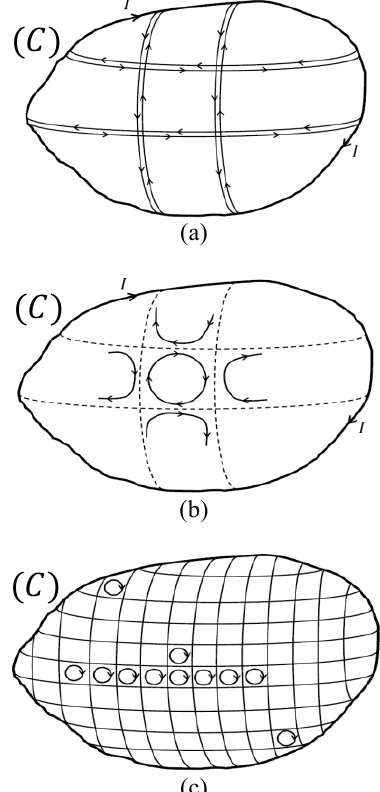
Figure 7: Set of small current loops equivalent to a large one